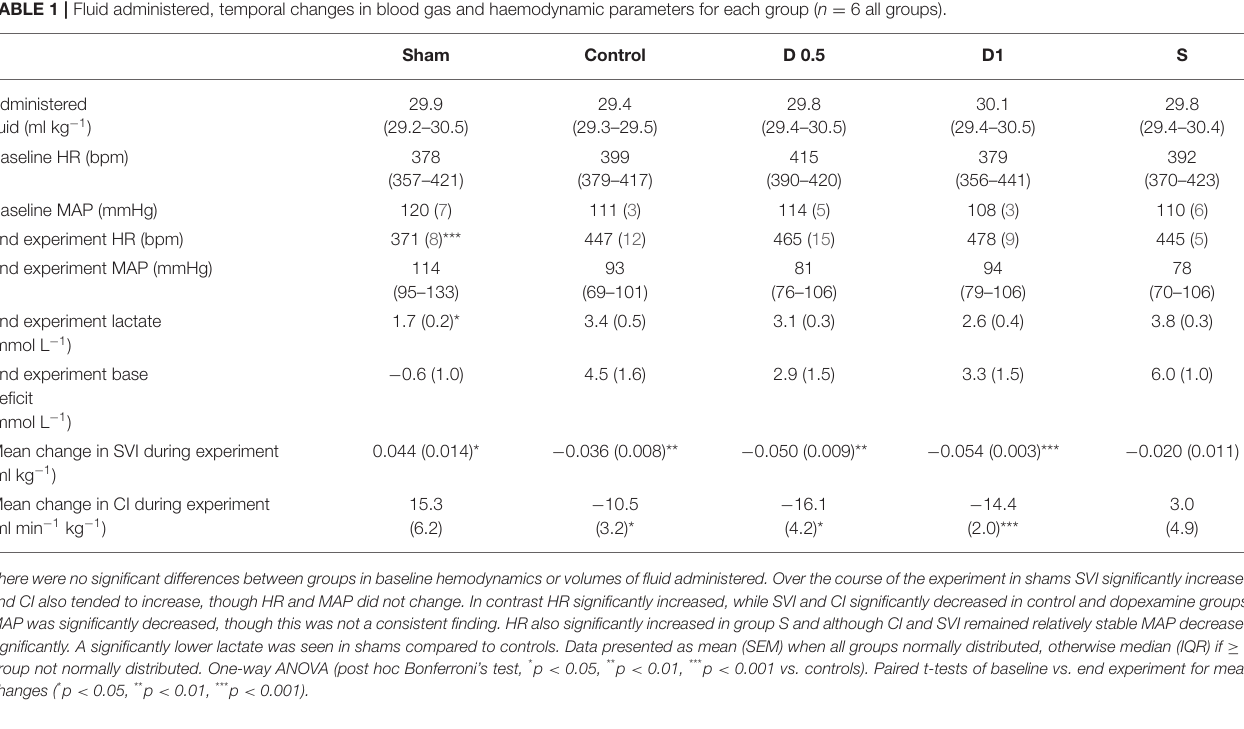
layers did not differ significantly from shams [ Figure 2 (right), Supplementary Figure 4 ]. Endotoxemia was associated with acute kidney injury but not liver dysfunction ( Figure 3 ). Dopexamine infusion had no significant effect on any haemodynamic parameters when compared